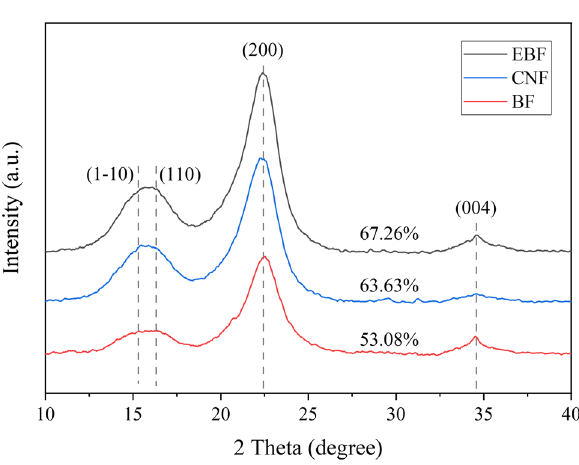
Figure 5. XRD patterns of BFs, EBFs, and CNFs.